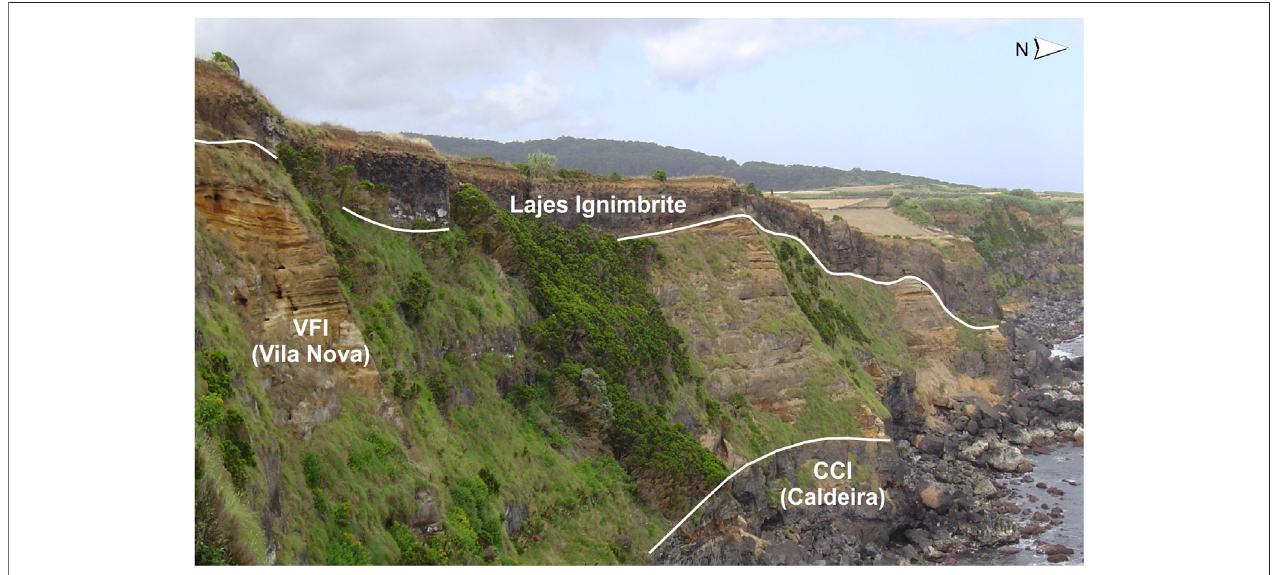
FIGURE 9 | View ofcliffsalongthe north coast of Terceira showing the Lajes Ignimbrite overlying a sequence ofolder pyroclastic formations containing ignimbrites (VFIandCCI)separatedbymajorerosionsurfaces.Abbreviationsareasgivenin Figure2 ;membersaregiveninparenthesis.Cliffis30 mhighintheforeground(leftside of the